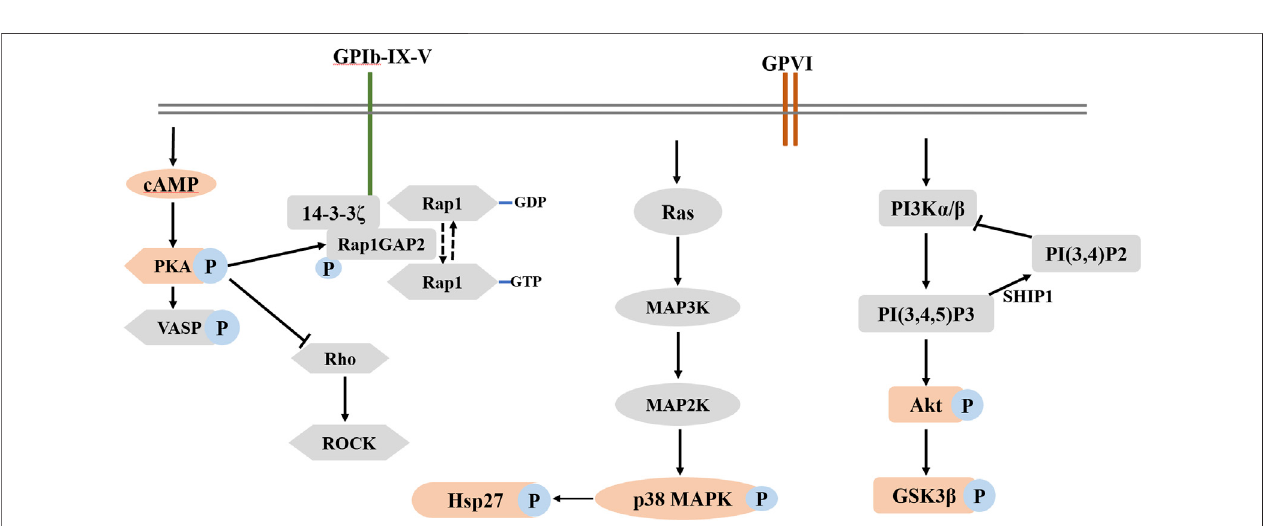
FIGURE 6 | Potential mechanism of action of fruit fl ow in collagen-stimulated